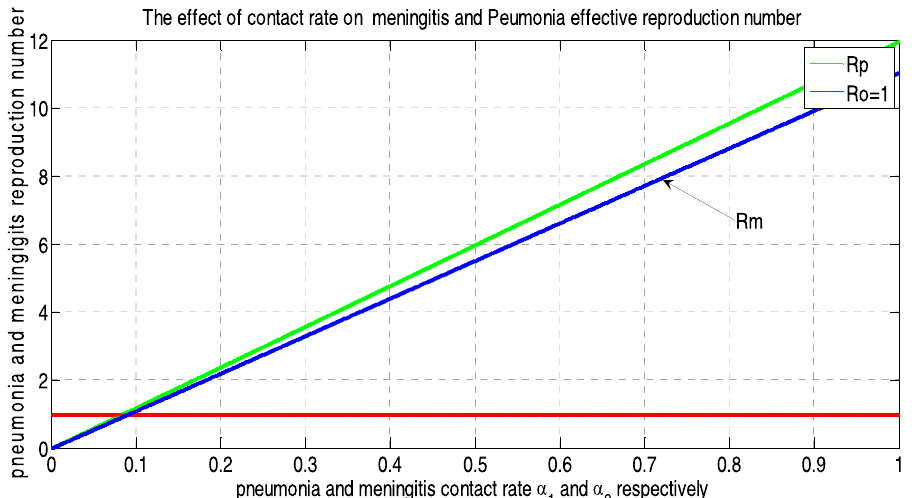
Figure 7. Effect of contact rate on meningitis and pneumonia effective reproduction number.